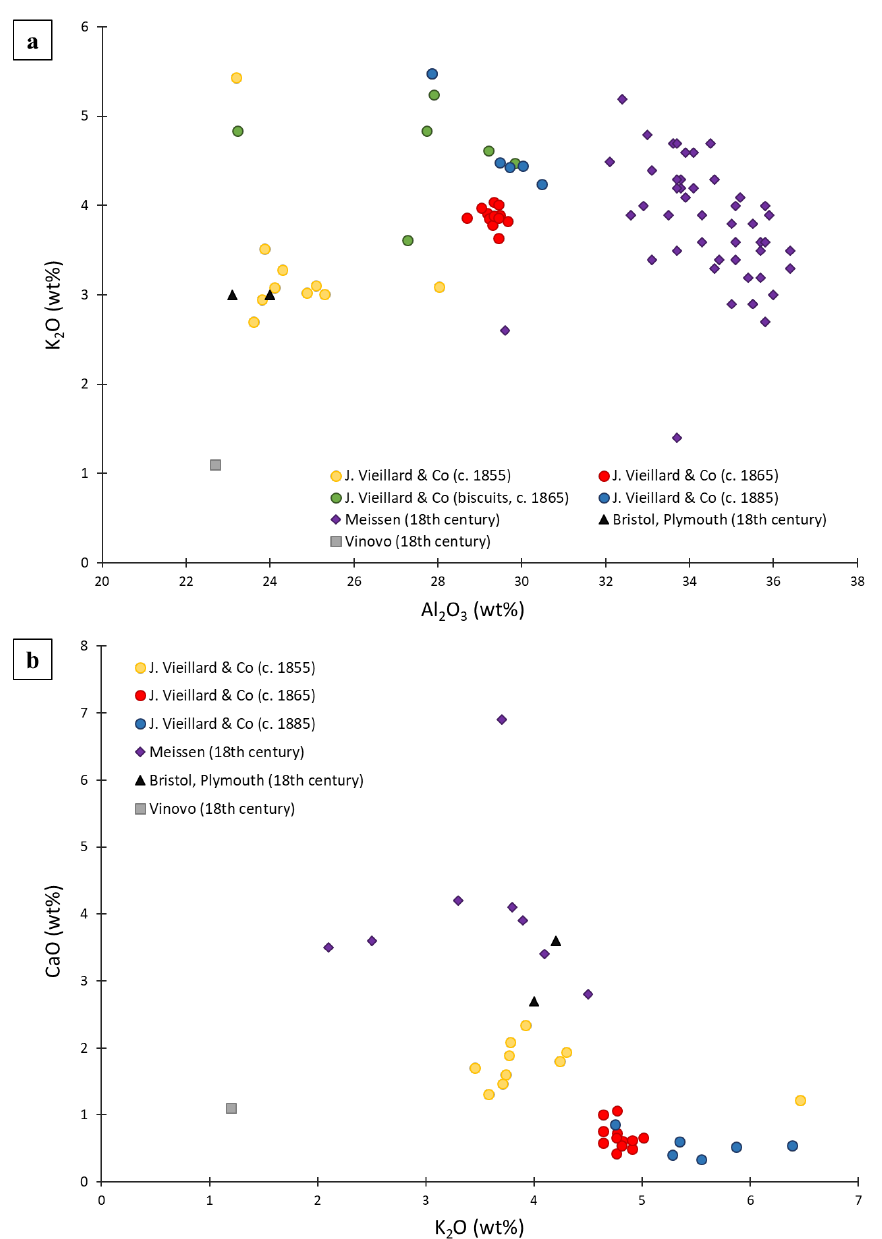
Figure 9. Bivariate plots of ( a ) K 2 O vs. Al 2 O 3 to compare the composition of porcelain bodies of Vieillard & Co measured by EDS to other European porcelains and ( b ) CaO vs. K 2 O to compare the composition of porcelain glazes of Vieillard & Co measured by EDS to other European porcelains. The compositional data used for comparisons were published in Schulle and Ullrich, 1982; Ullrich et al., 2010; Domoney et al., 2012; Bezur and Casadio, 2009; Neelmeijer et al., 2014 (for the Saxon manufactory of Meissen), in Tite and Bimson, 1991 (for two English factories) and in Turco et al., 2016 (for the Italian manufactory of Vinovo).